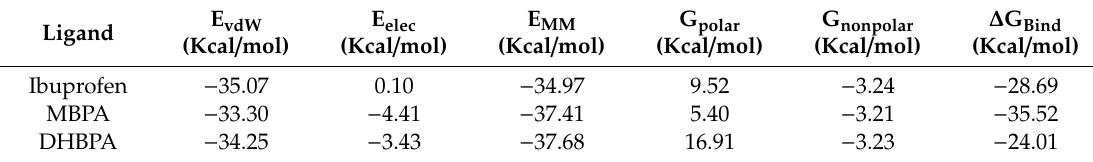
Table 2. Binding free energy and components, calculated using MM / PBSA. ∆ G E vdW E elec E MM G polar G nonpolar Bind Ligand (Kcal / mol) (Kcal / mol) (Kcal / mol) (Kcal / mol) (Kcal / mol) (Kcal / mol) Ibuprofen − 35.07 0.10 − 34.97 9.52 − 3.24 − 28.69 MBPA − 33.30 − 4.41 − 37.41 5.40 − 3.21 − 35.52 DHBPA − 34.25 − 3.43 − 37.68 16.91 − 3.23 −